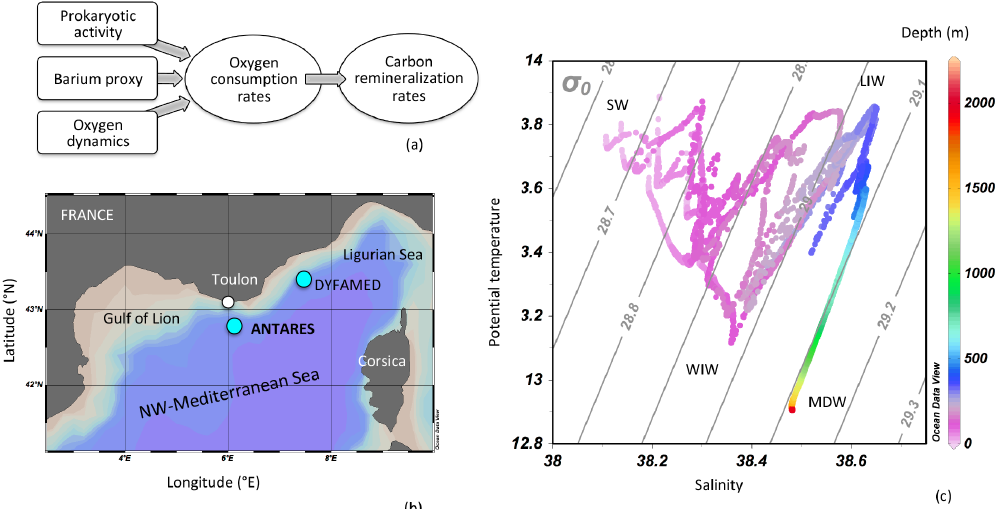
Figure 1. (a) Schematic representation of the convergence of the different estimators of oxygen consumption and C remineralization rates from the “oxygen dynamics”, “barium proxy” and “prokaryotic activity” tools; (b) location of the BATMAN cruise at the ANTARES obser- vatory site in the NW Mediterranean Sea (42 ◦ 48 (cid:48) N, 6 ◦ 10 (cid:48) E). The location of the DYFAMED station is reported for comparison (Sternberg et al., 2008); (c) potential temperature–salinity–depth plots and isopycnals for BATMAN profiles. SW: Surface Water; WIW: Winter Interme- diate Water; LIW: Levantine Intermediate Water; DMW: Deep Mediterranean Water. Graph constructed using Ocean Data View (Schlitzer, 2002; Ocean Data View; http://www.awi-bremerhaven.de/GEO/ODV, last access: 2 March